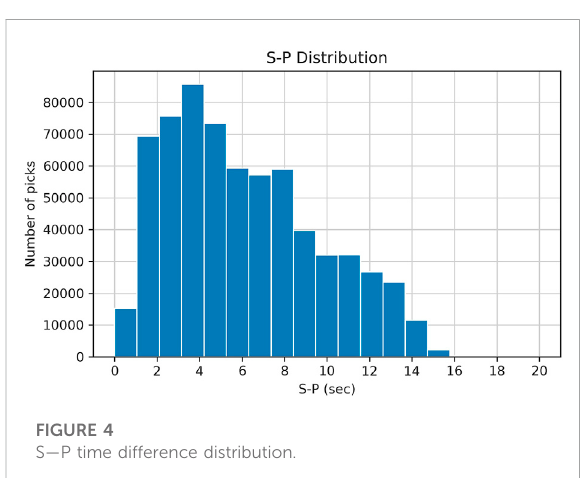
FIGURE 4 S — P time difference